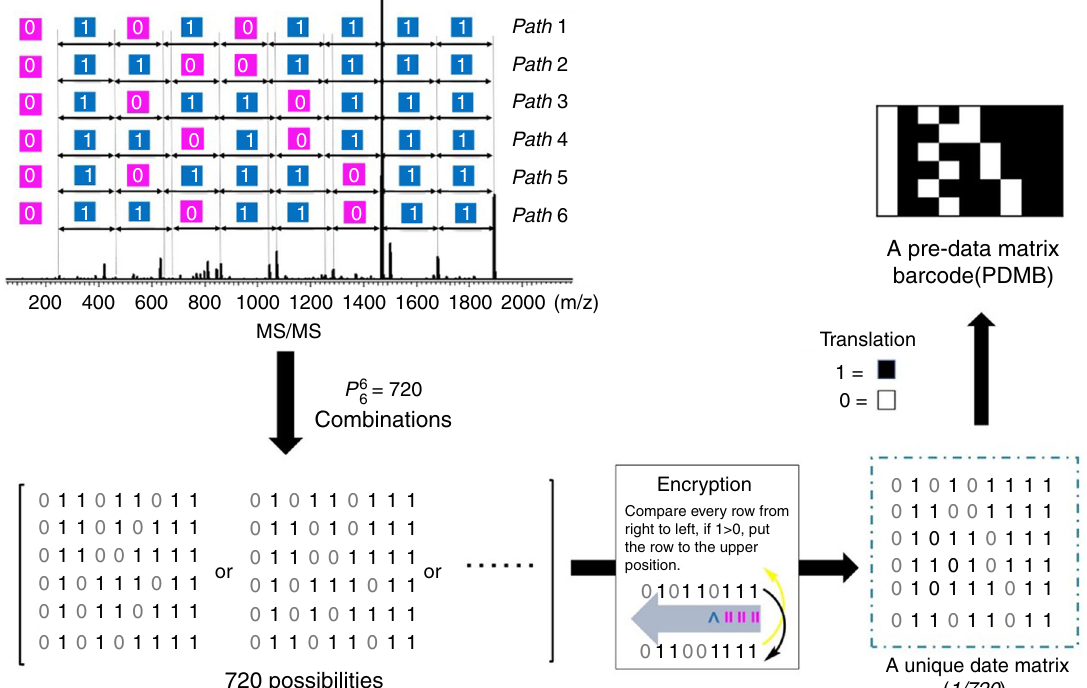
Fig. 4 Translation from MS/MS fragmentation pattern of DN-011-G1 to data matrix